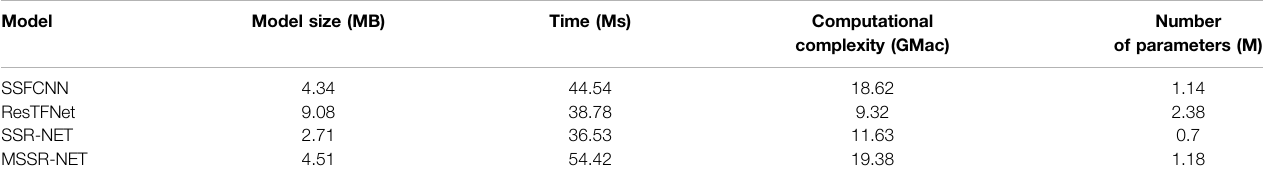
TABLE 8 | Model complexity analysis on Urban datset using NVIDIA GeForce RTX 3090 GPU.